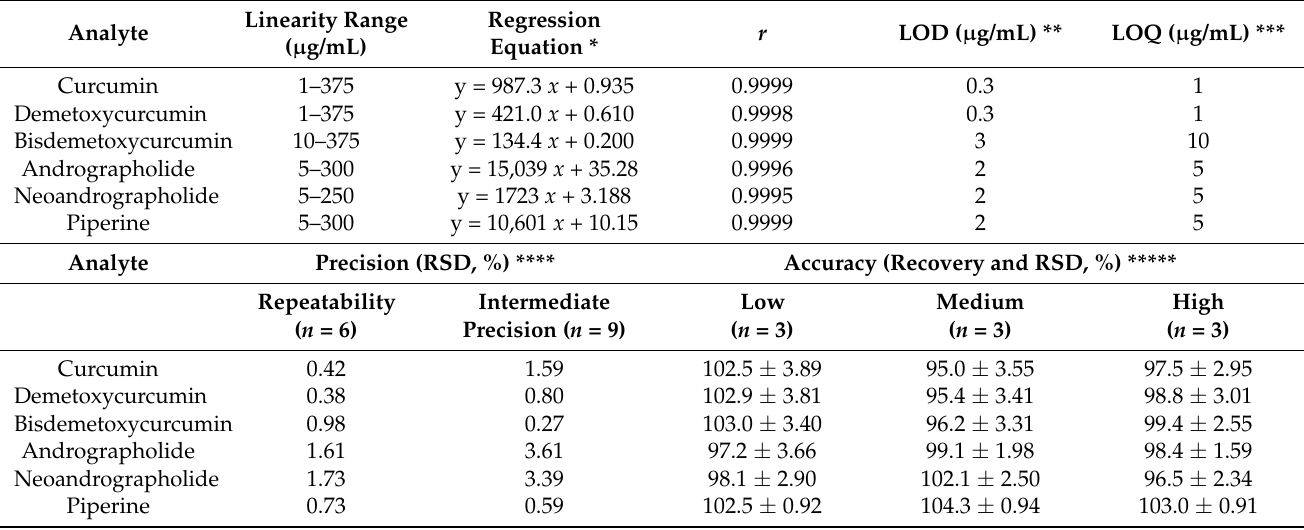
Table 2. Shake-flask method validation data.